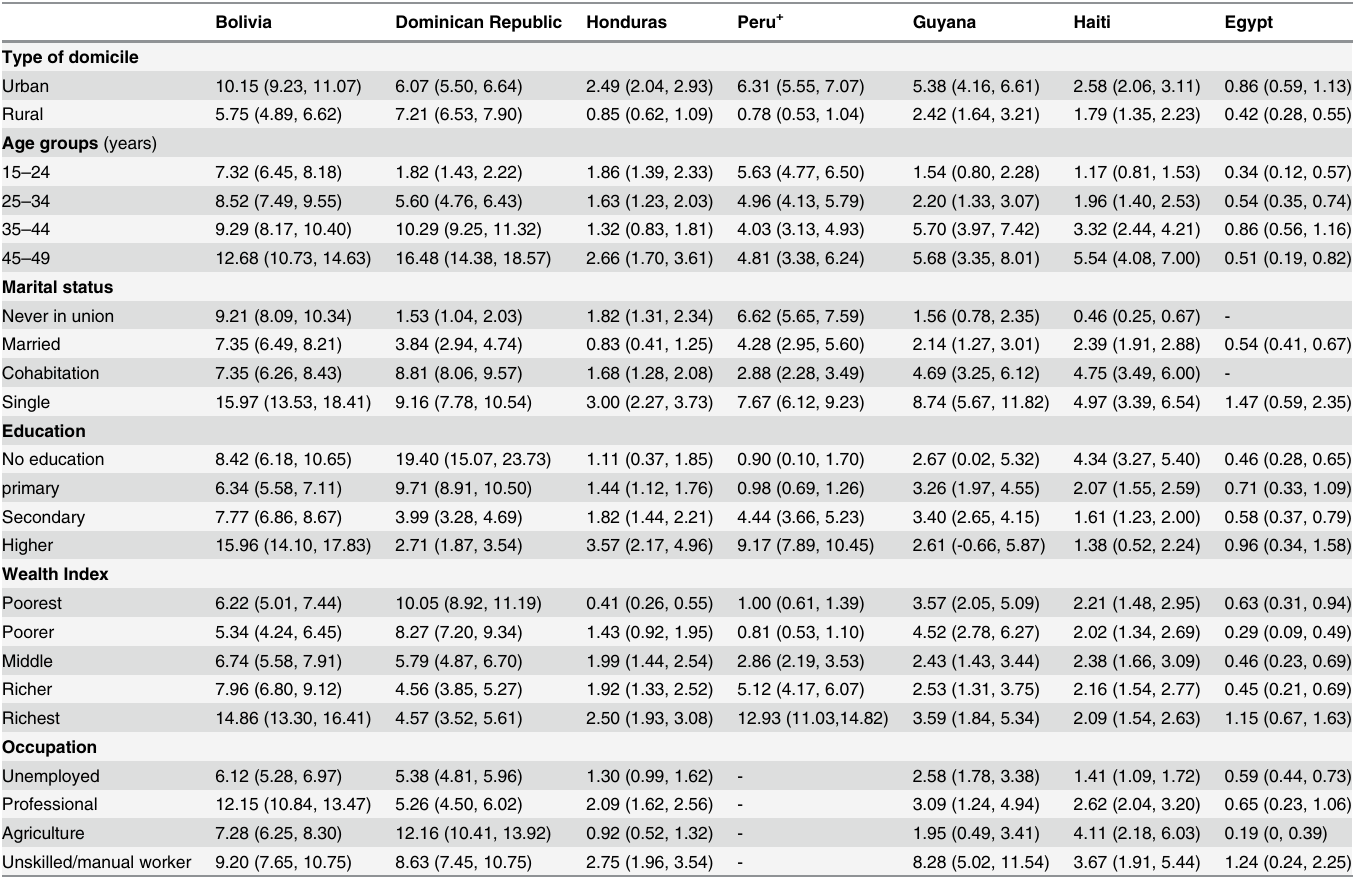
Table 5. Weighted prevalence estimates (%) and 95% CIs of smoking by social factors among women in 7 countries (Latin America, Caribbean and North